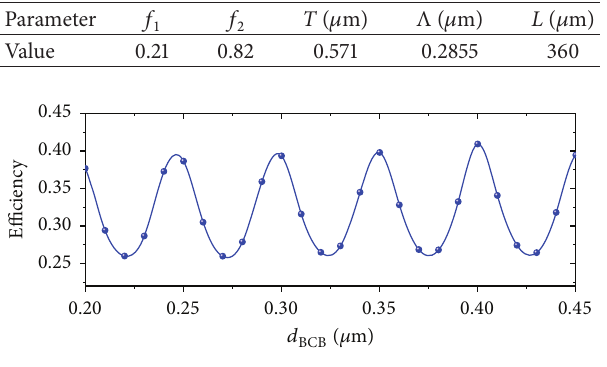
Figure 5: Coupling efficiency with 𝑑